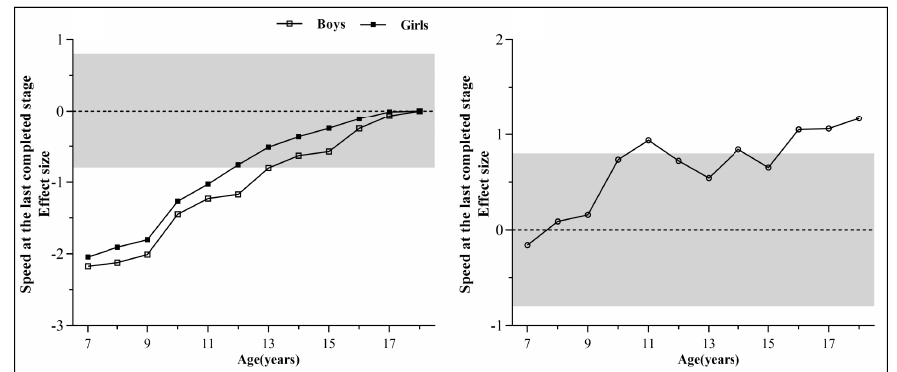
Figure 2. Standardized differences in mean 20mSRT performance (the speed at the last completed stage, km h − 1 ). Note: Between sex-matched Chinese Tibetan children and adolescents of different ages (anchored to age 18 years = 0) and age-matched Chinese Tibetan boys and girls. Positive differences indicate that 20mSRT performances were higher for older children than for younger children or for boys than for girls. The limits of the grey zone represent the thresholds for a large standardized difference (0.8 or −